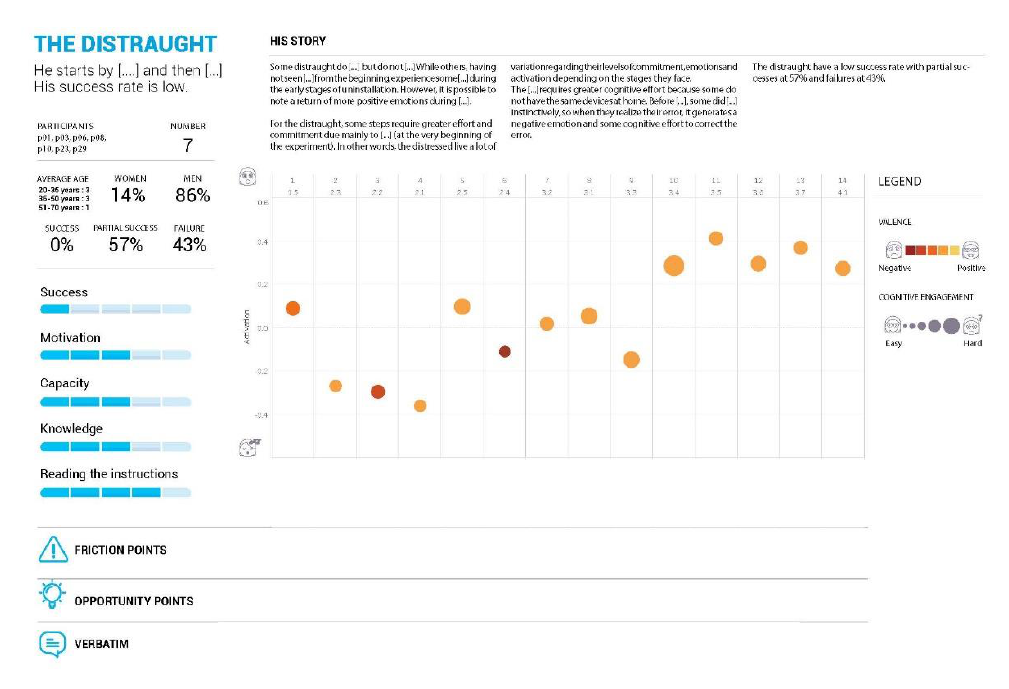
Figure 11. CJM of the Distraught.